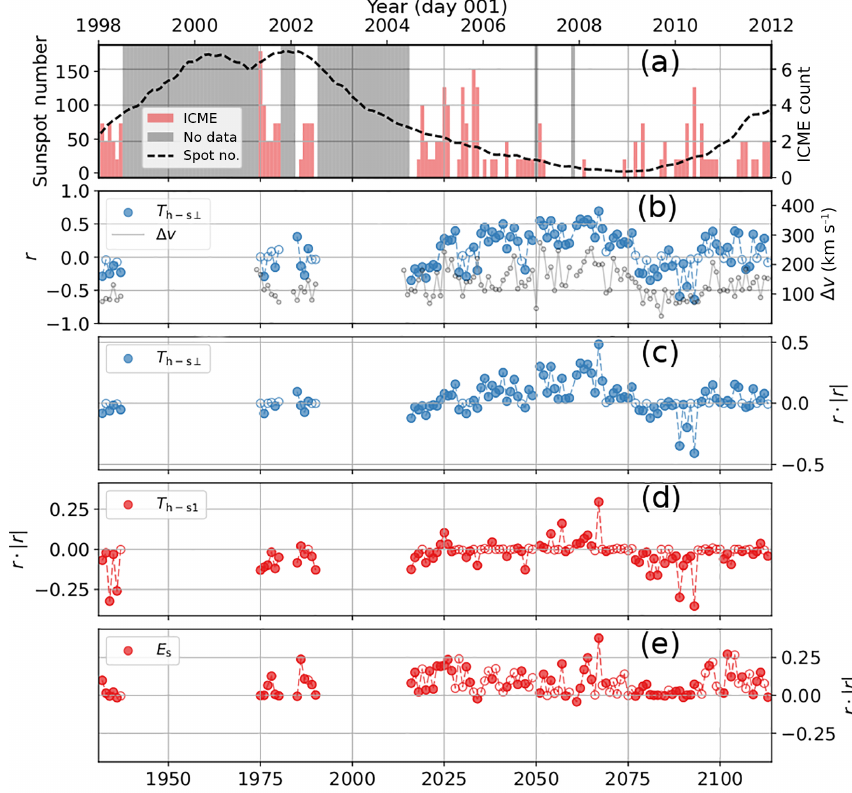
Figure 8. Linear correlation data for suprathermal electron parameters with O 7 + / O 6 + , as calculated over single Carrington rotations against time. Also shown are supporting solar and heliospheric data. Time is shown as years on the top axis and Carrington rotation number on the bottom. All correlation data ( r or r · r ) are shown as a filled in point only when the corresponding p value is < 0 . 05; otherwise it is outline only. (a) Monthly sunspot number is plotted as a dashed line. A sunspot maximum followed by a minimum can be seen over the course of the observations. Also plotted is a histogram of the number of ICME detections at L1 from the Richardson and Cane list (Richardson and Cane, 2010). Greyed-out boxes correspond to gaps resulting from a lack of WIND electron data. The time for the minimum in ICMEs leads that of sunspot minimum by 1–2 years. This period has some agreement with that of strongest T h–s ⊥ -O 7 + / O 6 + correlation in 2007–2008. (b) The left axis plots the correlation coefficient r calculated for the pairing T h–s ⊥ -O 7 + / O 6 + . The right axis plots the value (cid:49)v , which describes the range of the velocity data sampled as a difference of upper and lower quartiles (detailed in text). There is some apparent tracking between these two parameters, notably in the period following 2006. (c) r · r for the correlation coefficient between T h–s ⊥ and O 7 + / O 6 + . The fractional dependence of the two parameters on each other is clearly less that 20% for most Carrington rotations. A notable exception to this is the period of enhanced positive correlation around the time 2007–2008. (d) The same plot as (c) , with T h–s ⊥ replaced by T h–s1 . The magnitude of r · r is almost uniformly smaller than for T h–s ⊥ . (e) r ·| r | for the linear correlation r calculated for E s with O 7 + / O 6 + . For most Carrington rotations there is a weak, positive, relationship. There are no notable Carrington rotations in which there is a negative